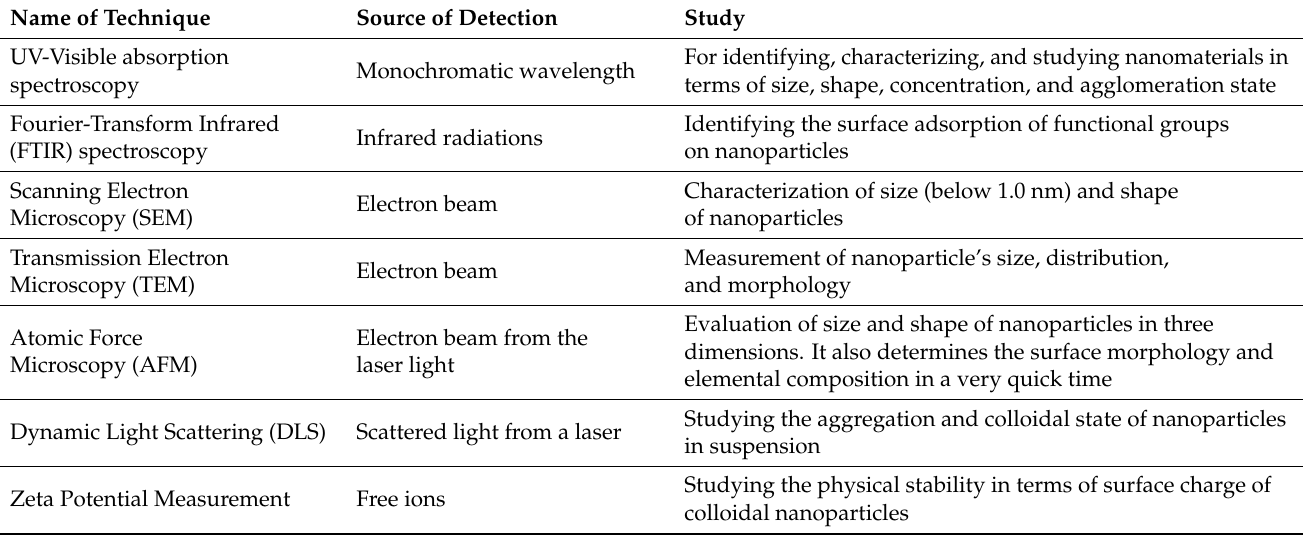
Table 1. The details of techniques that are widely used to characterize the PDMNPs